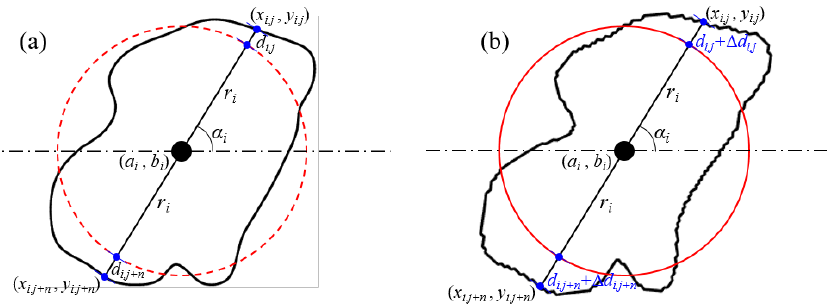
Figure 8. The principle of grain roundness change. ( a ) Original relationship between grain boundary and mapping circle. ( b ) The relationship between them with the mapping distance increasing Δ d ij .